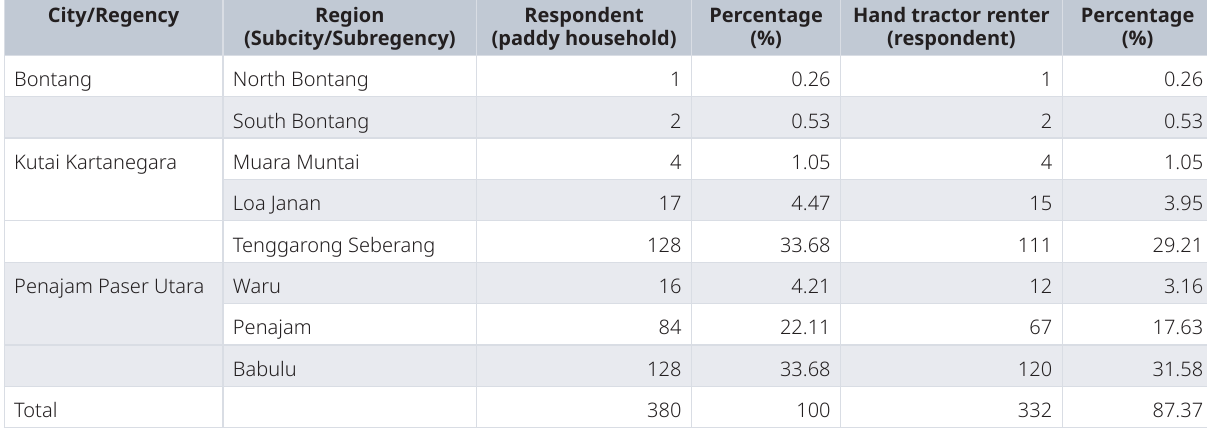
Table 3. Number of respondents who were hand tractor renters in East Kalimantan the year 2014.